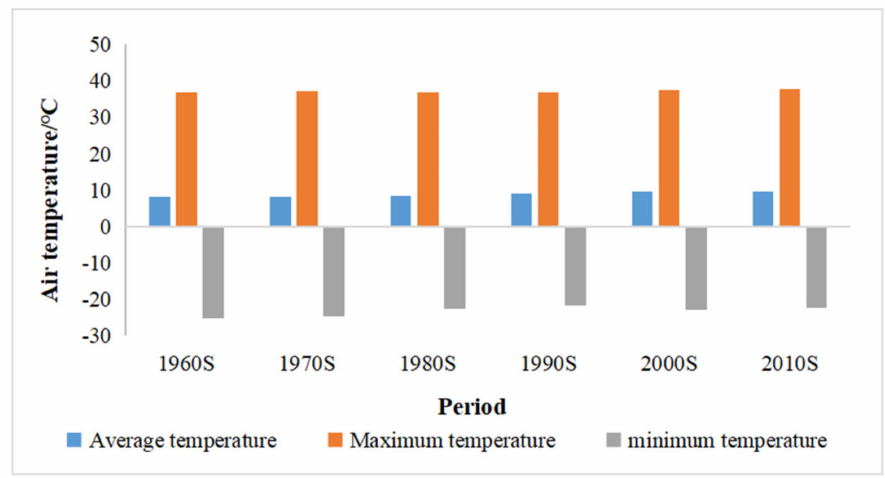
Figure 8. Interdecadal variation of the mean temperature in Xinjiang during 1961–2020.